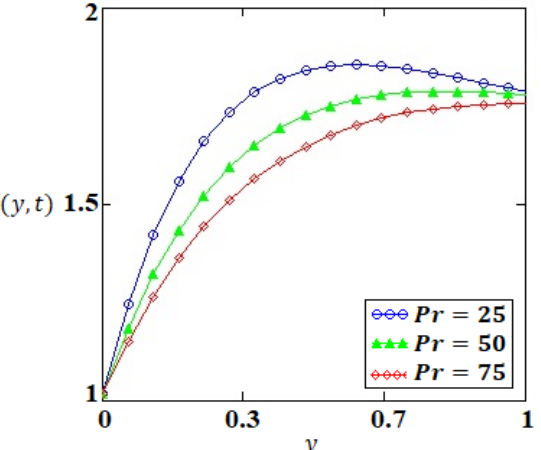
Figure 3. Graphical illustration of fractional approach of Caputo-Fabrizio with ℛ (cid:2868) = 1, 𝐾 (cid:2868) = 0.4, 𝑍𝑇 = 3.7, 𝜔 = 0.5, 𝑀 = 0.5, 𝛼 = 0.6, 𝑡 = 1 for different Prandtl number values. (cid:2868)